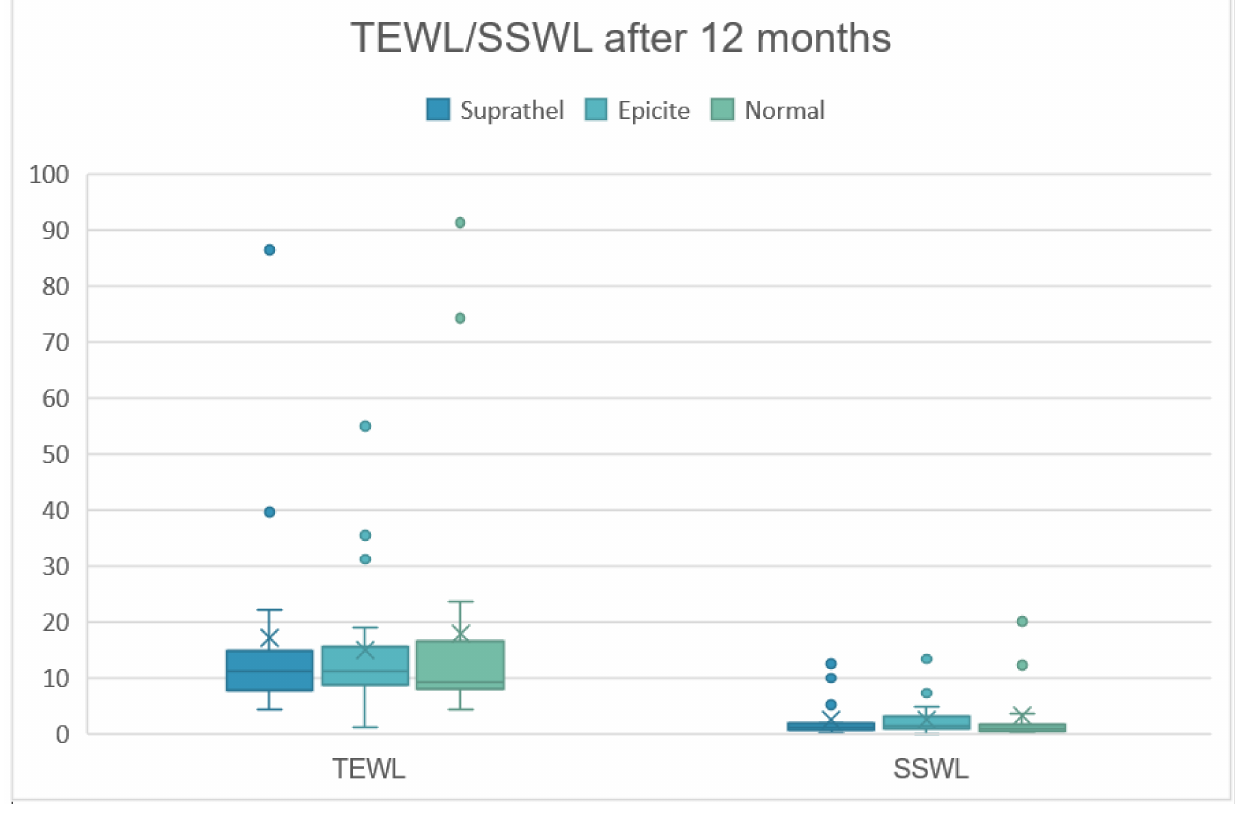
Figure 5. Trans-epidermal water loss (TEWL) and skin surface water loss (SSWL) in g/h/m 2 of treated and untreated areas after 12 months. Table 4. O2C measurements in mean and SD (standard derivation) after 3, 6 and 12 months of treated and untreated areas (oxygen saturation sO 2 in %; relative Hemoglobin (rHb) value and flow in arbitrary